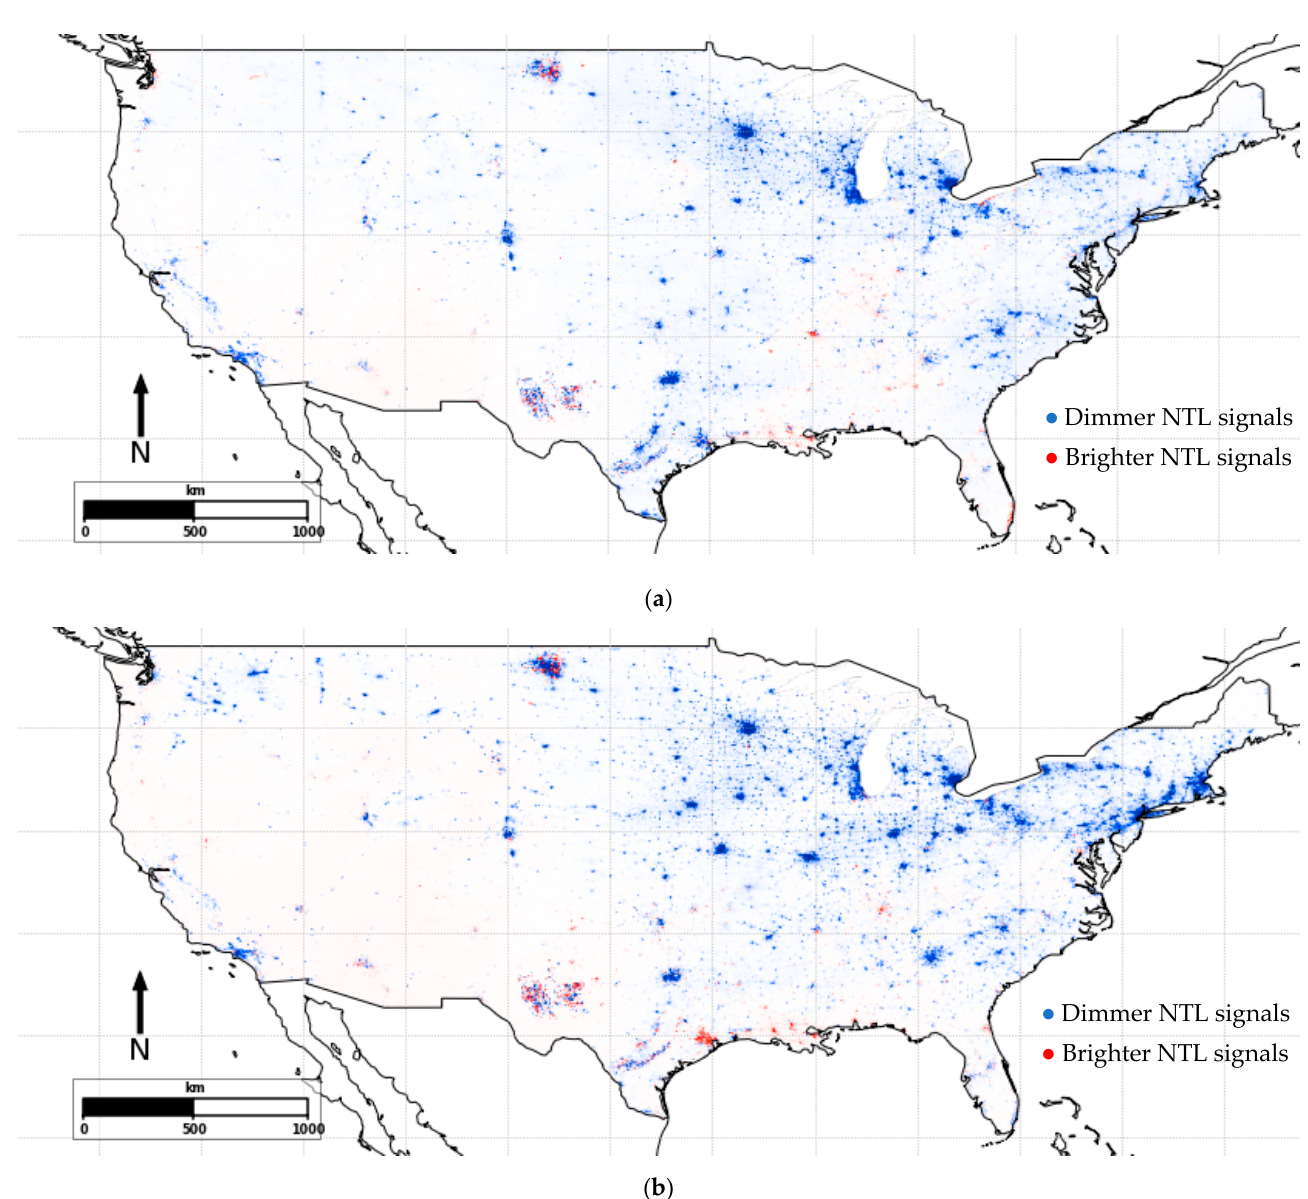
Figure 1. Changes in night lights after the COVID-19 pandemic: March 2020 vs. February 2020 ( a ) and March 2020 vs. March 2019 ( b ). Blue and red pixels stand, respectively, for dimmer and brighter NTL signals. Source: Authors’ calculations based on VIIRS data from the Earth Observation Group and Google Earth Engine [32].